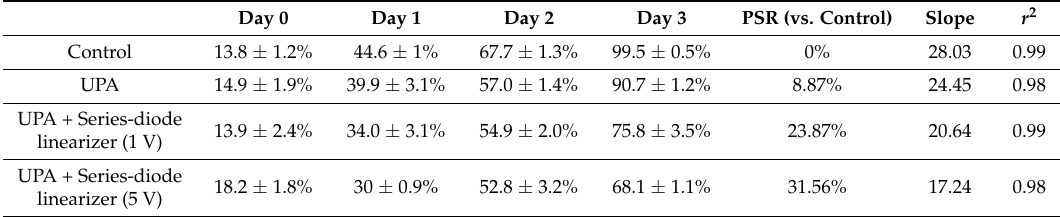
Figure 8. HeLa cells suppression experiments when exposed to the isolated ultrasonic power amplifier and the ultrasonic power amplifier integrated with series-diode linearizer from Day 0 to Day 3. SR refers to proliferation suppressing ratio. UPA, UPA + series-diode-linearizer (1 V), and UPA + series-diode-linearizer (5 V) represent ultrasonic induction when using the isolated ultrasonic power amplifier and the ultrasonic power amplifier with series-diode linearizer at 1 V DC bias voltage, and ultrasonic power amplifier with series-diode-linearizer at 5 V DC bias voltage, respectively. * p < 0.05. Table 1. Summary of quantitative data of cell densities with or without ultrasonic stimulus, PSRs, and slope with r 2